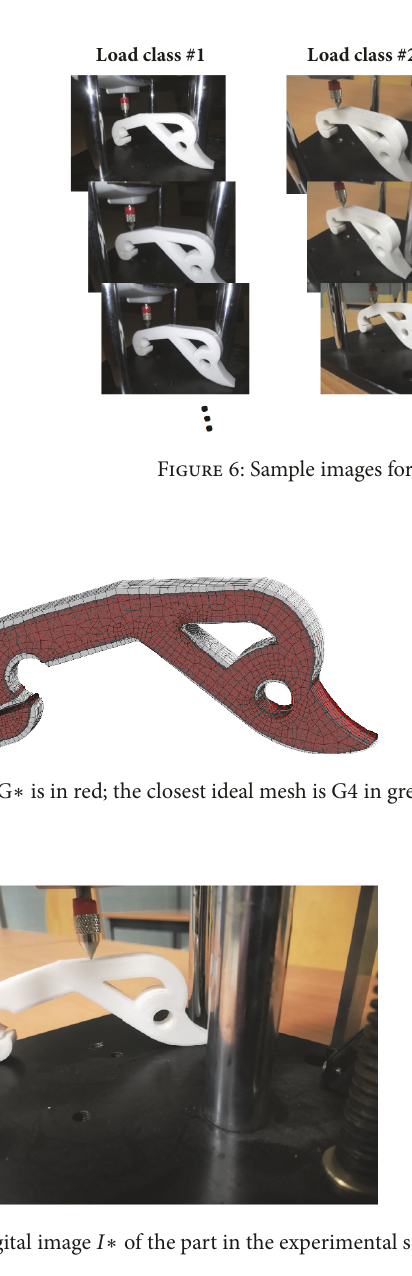
Figure 8: Digital image 𝐼∗ of the part in the experimental setup.